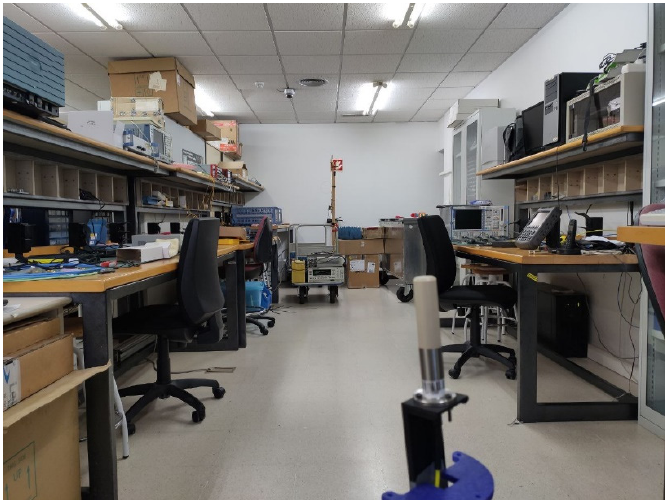
Figure 8. Transmitter and receiver inside the laboratory.